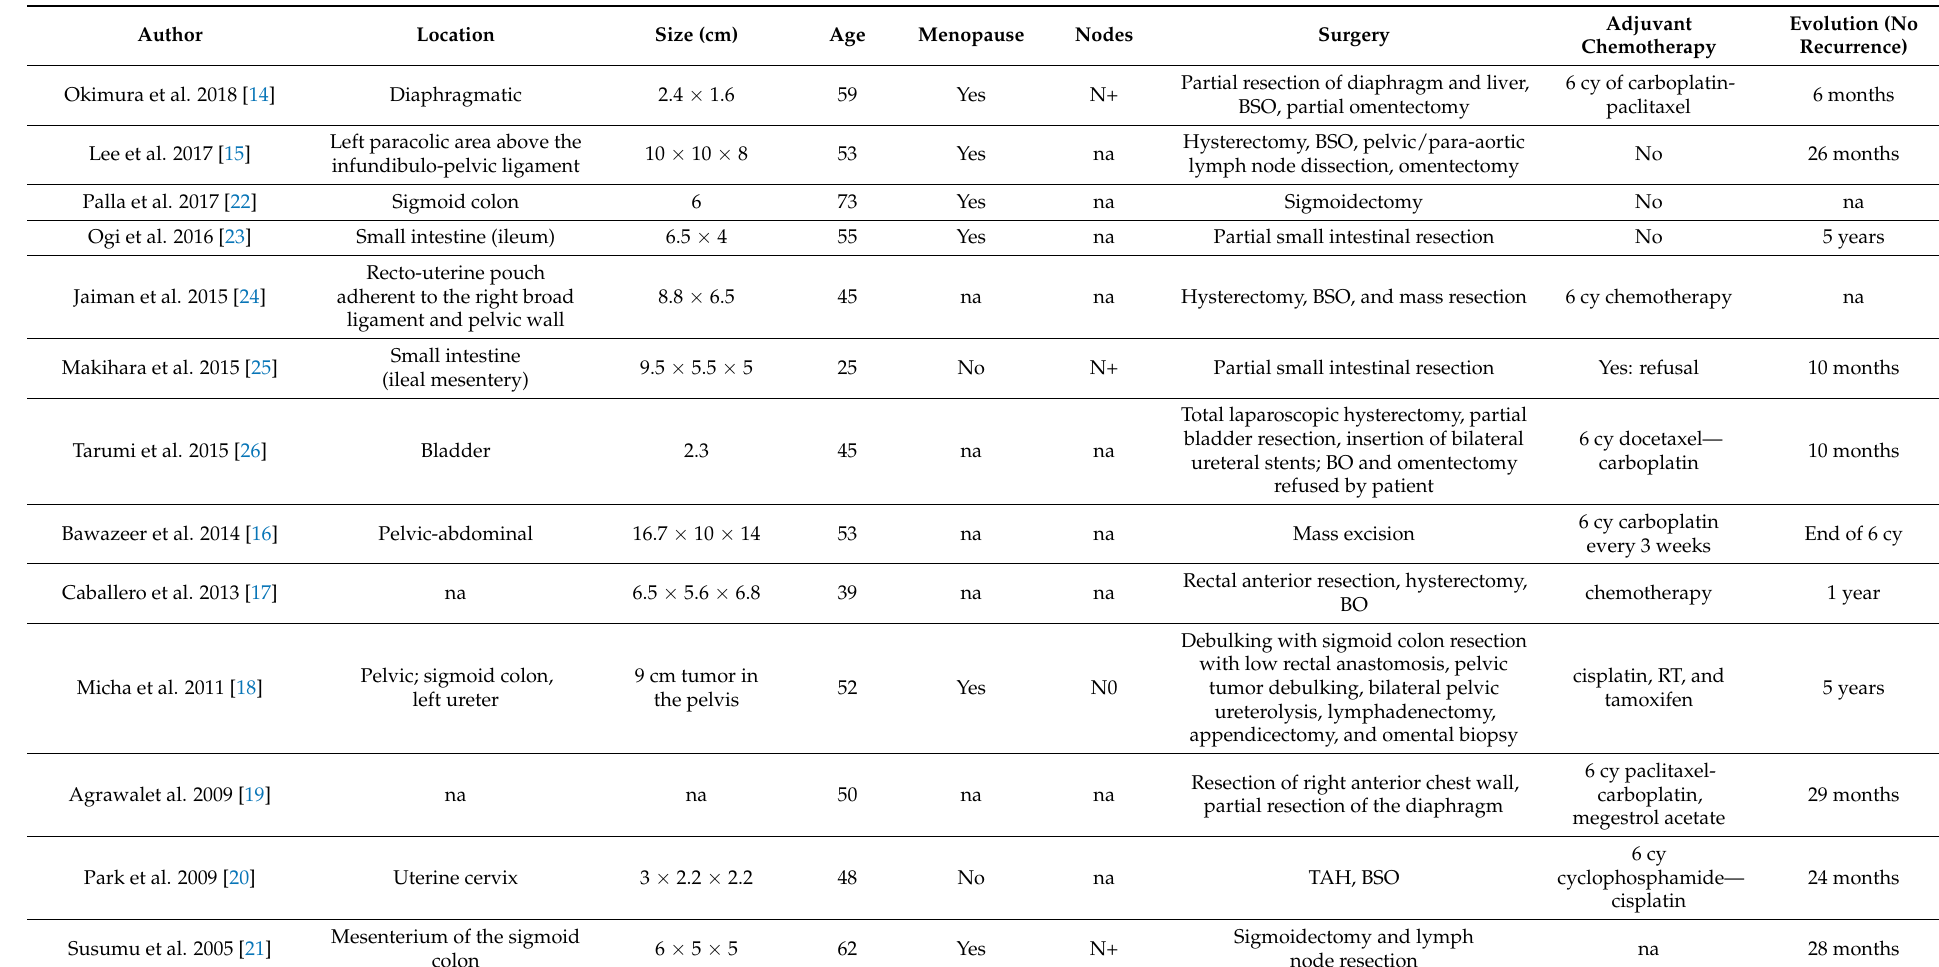
Table 2. Literature research of extraovarian and extrauterine endometrioid adenocarcinoma arising from